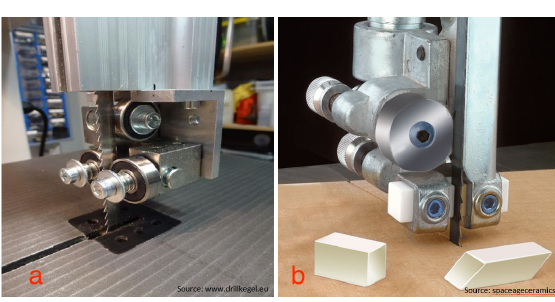
Figure 1. Typical bandsaw guides. ( a ) Bearing guides; ( b ) ceramic block